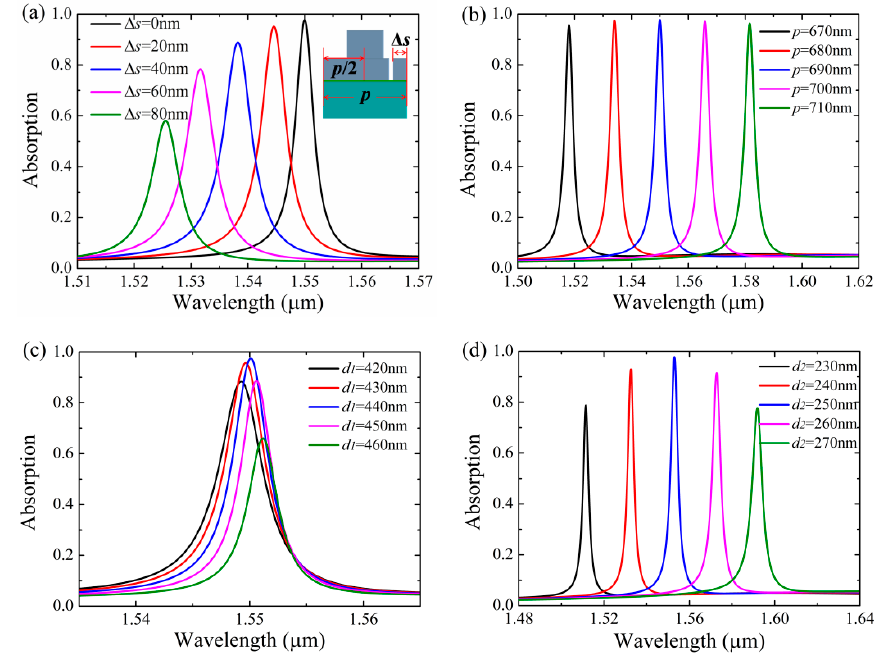
Figure 6. Absorption spectra of the Si-based PCS with graphene under the variations of structural parameters with s = 74 nm, other parameters are the same as Figure 2. ( a ) The lateral shift of the slit Δ s where Δ s is indicated in the figure inset. ( b ) The period p . ( c ) The thickness of the grating layer d 1 . ( d ) The thickness of the sublayer d 2 . Table 1. Key parameters of the absorption spectra of the Si-based PCS with graphene shown in Figure 6. Parameters